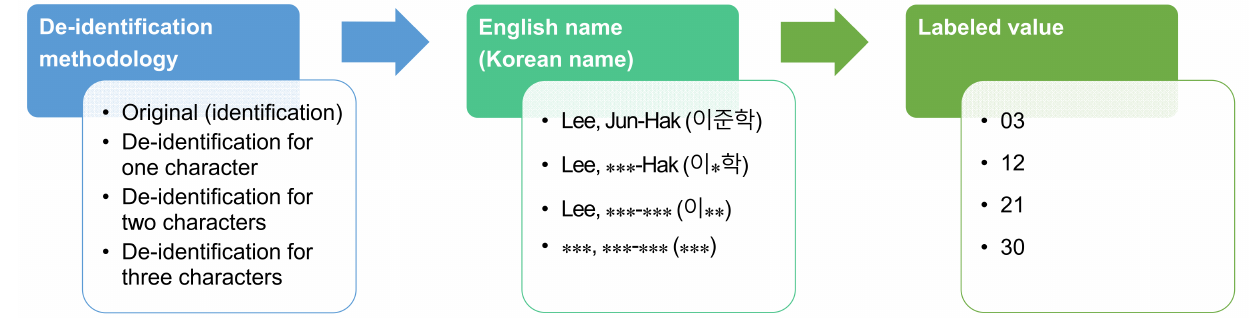
Figure 4. Labeling rules for the family name. An asterisk (*) indicates a de-identified character from personal